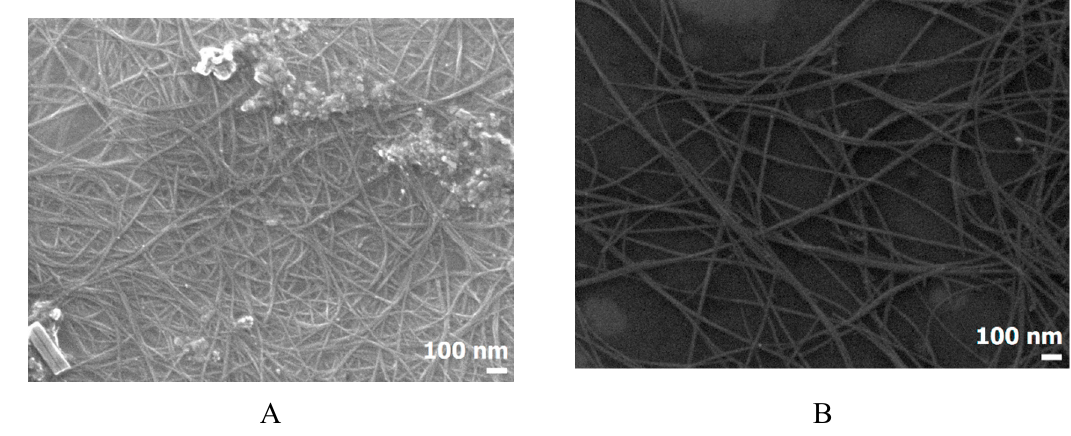
Figure 3. CNT SEM images. before ( A ) and after ( B ) CO 2 processing at a pressure of 75 bar and a temperature of 80 °C.